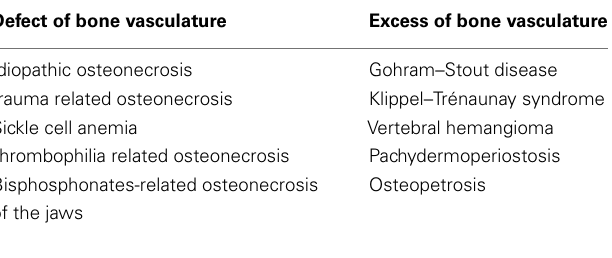
Table 1 | Main clinical manifestations of the altered bone/vasculature